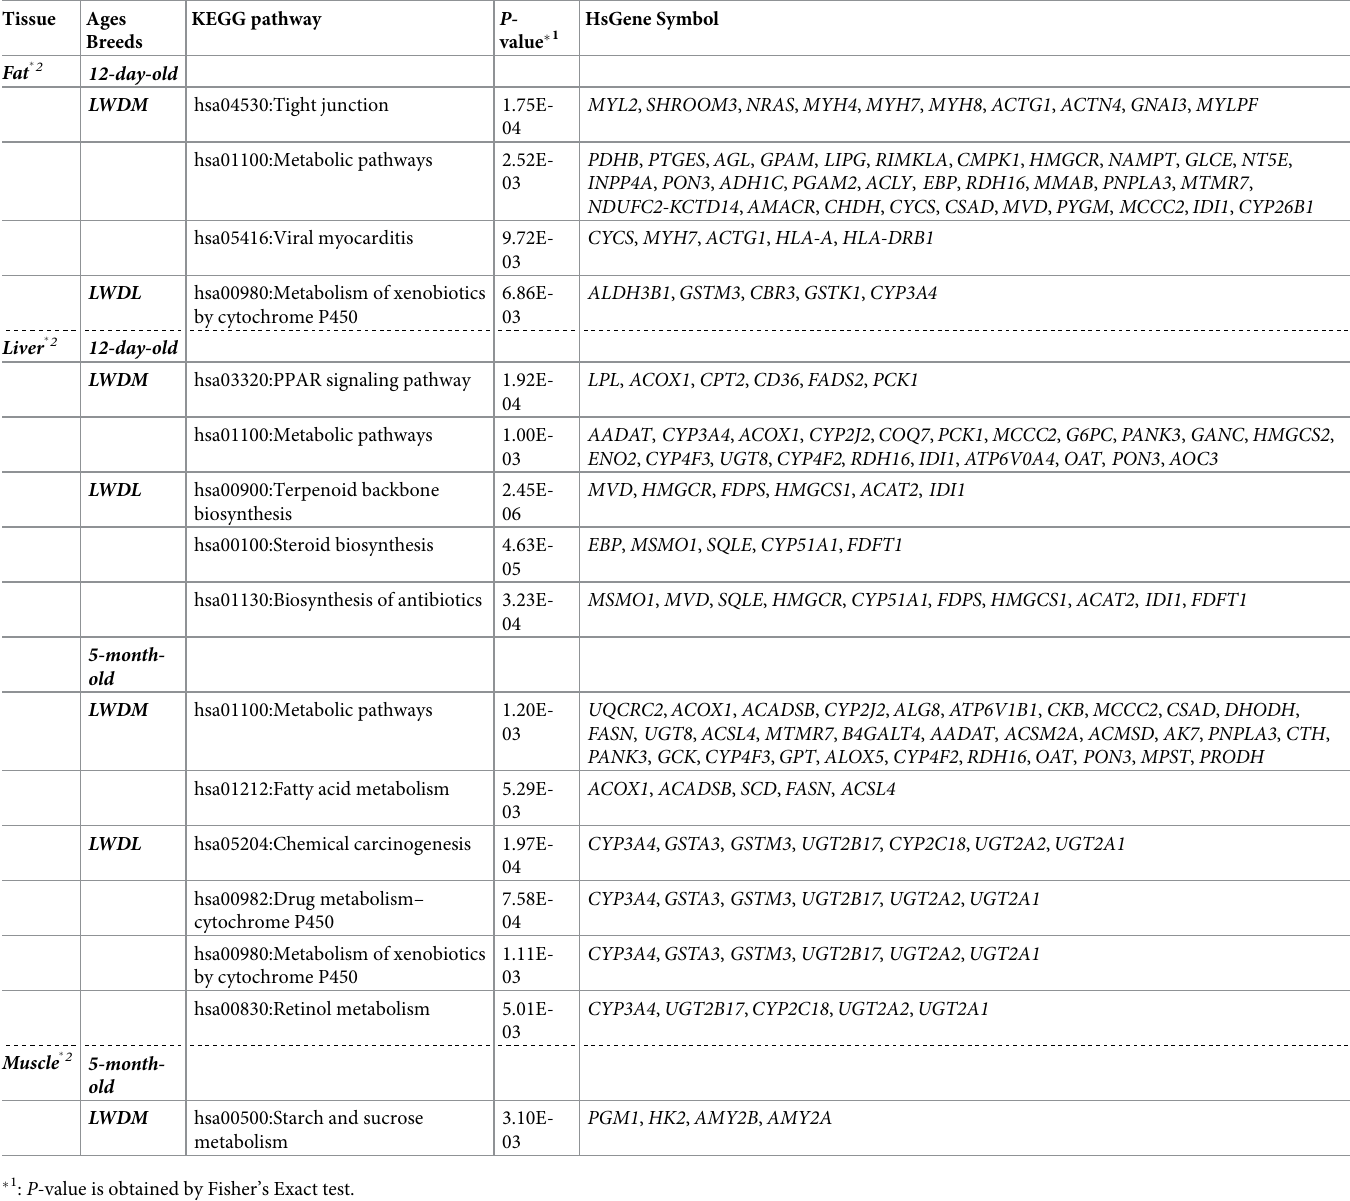
Table 4. Profile of Kyoto Encyclopedia of Genes and Genomes (KEGG) pathway for 2-fold higher expressed genes in the subcutaneous adipose (fat), liver and long- issimusdorsi muscle (muscle) tissues of LWDM and LWDL